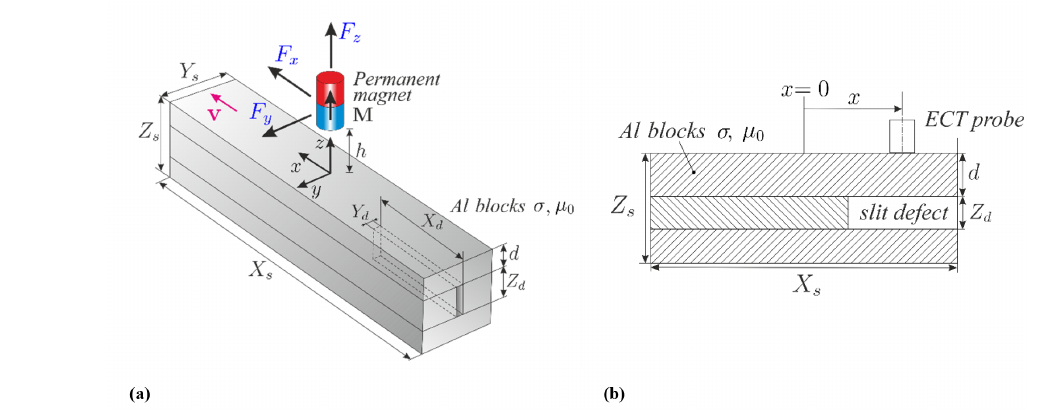
Figure 1. Measurement principles for LET (a) and ECT (b)